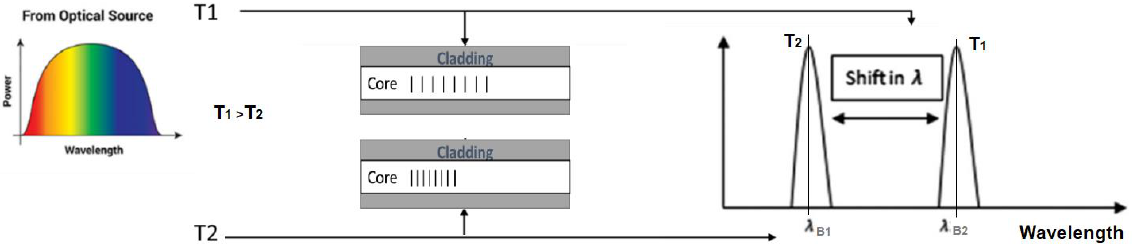
Figure 2. A conceptual example showing the effects of changing temperature on the base wave- length.